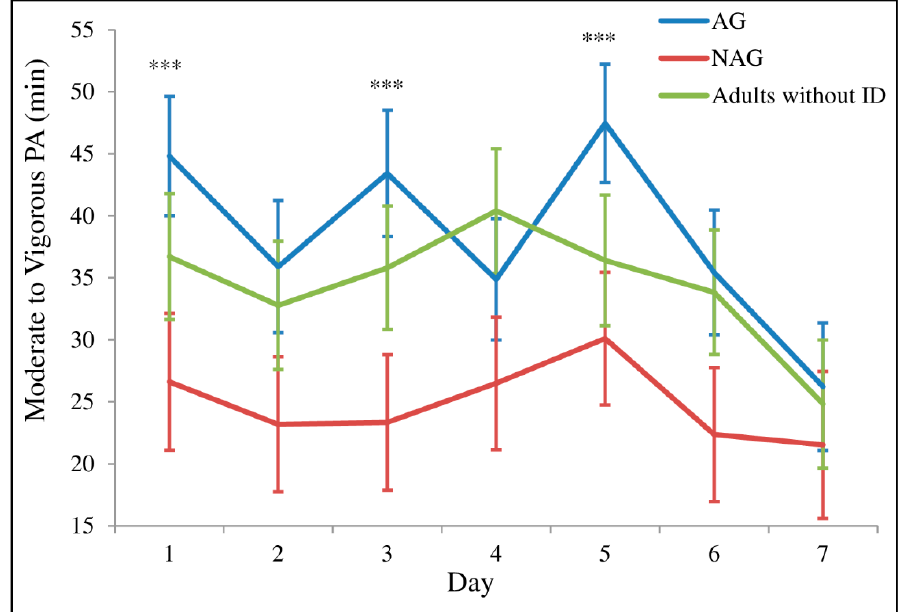
Figure 3. Time spent in moderate to vigorous physical activity throughout the week. 1 (Monday); 2 (Tuesday); 3 (Wednesday); 4 (Thursday); 5 (Friday); 6 (Saturday); 7 (Sunday). Values are means (standard error); n = 35 for AG (active group); n = 28 for NAG (non-active group); n = 31 for adults without ID. *** Significant difference ( p ≤ 0.05) between AG vs. NAG.